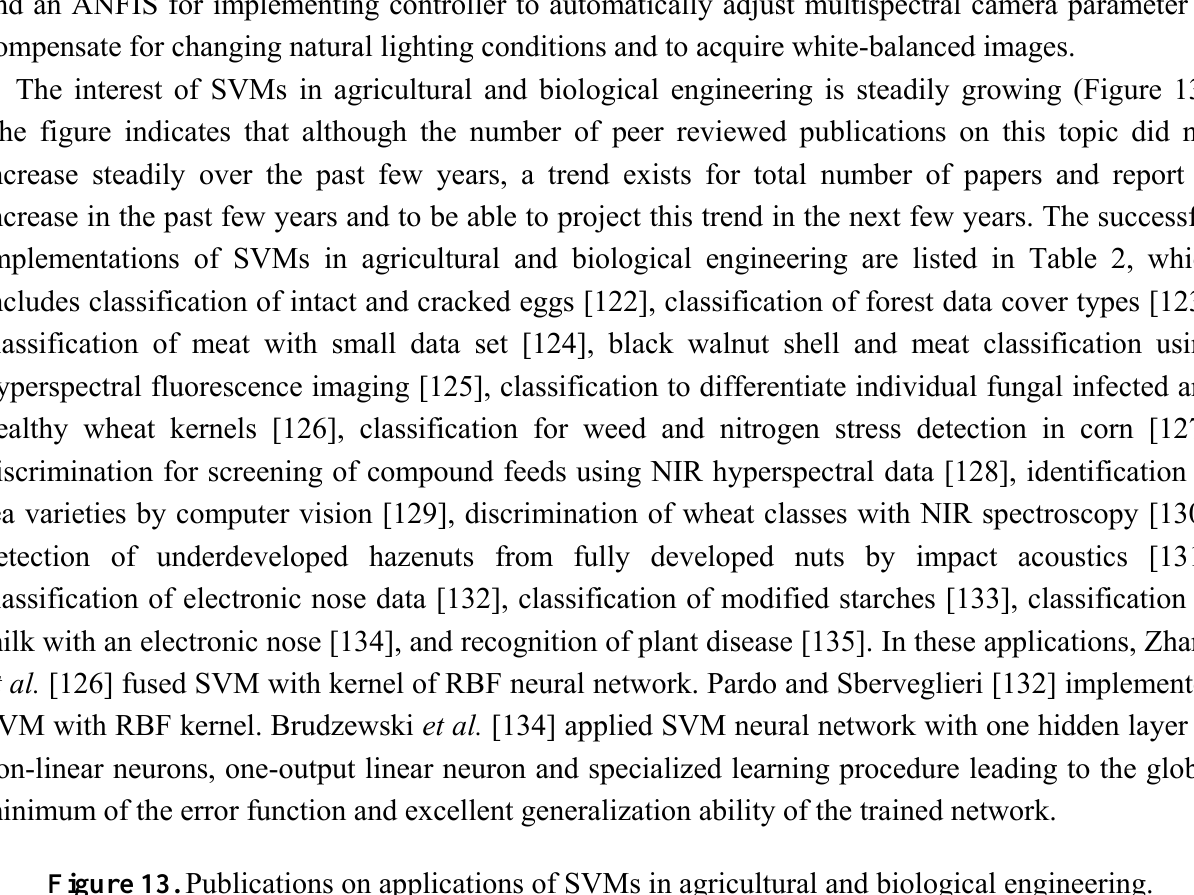
Figure 13. Publications on applications of SVMs in agricultural and biological engineering.